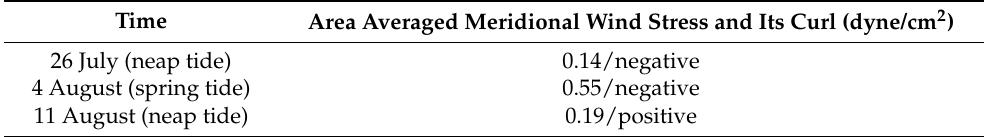
Table 2. Area-averaged wind stress in the region of 32 ◦ N–36 ◦ N, 120 ◦ E–124 ◦ E.